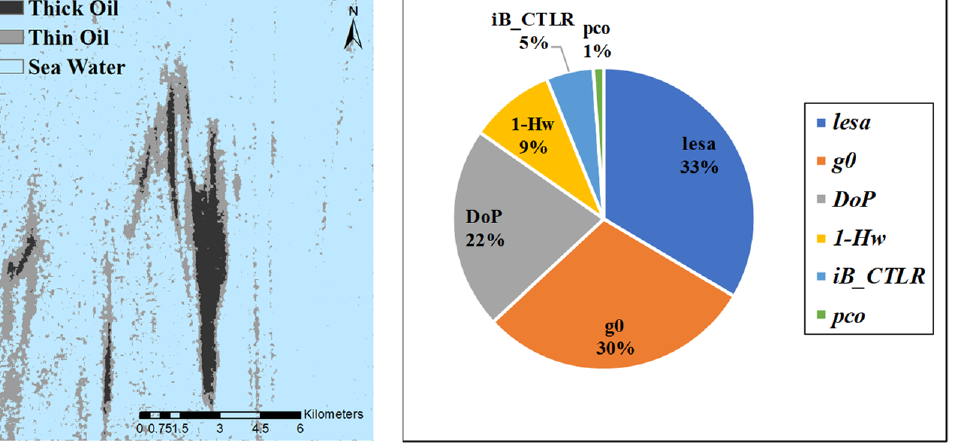
Figure 14. Random forest classification result graph and variable importance ranking for Case 1. Table 3. Classification accuracies of random forest classifier in Case 1.